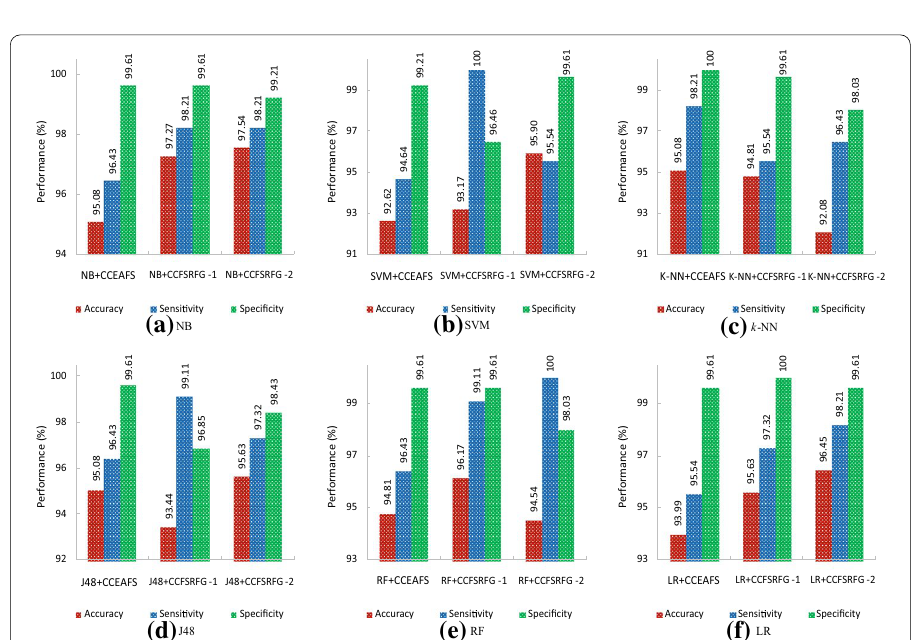
Fig. 7 Performance evaluation of classifiers on the Dermatology